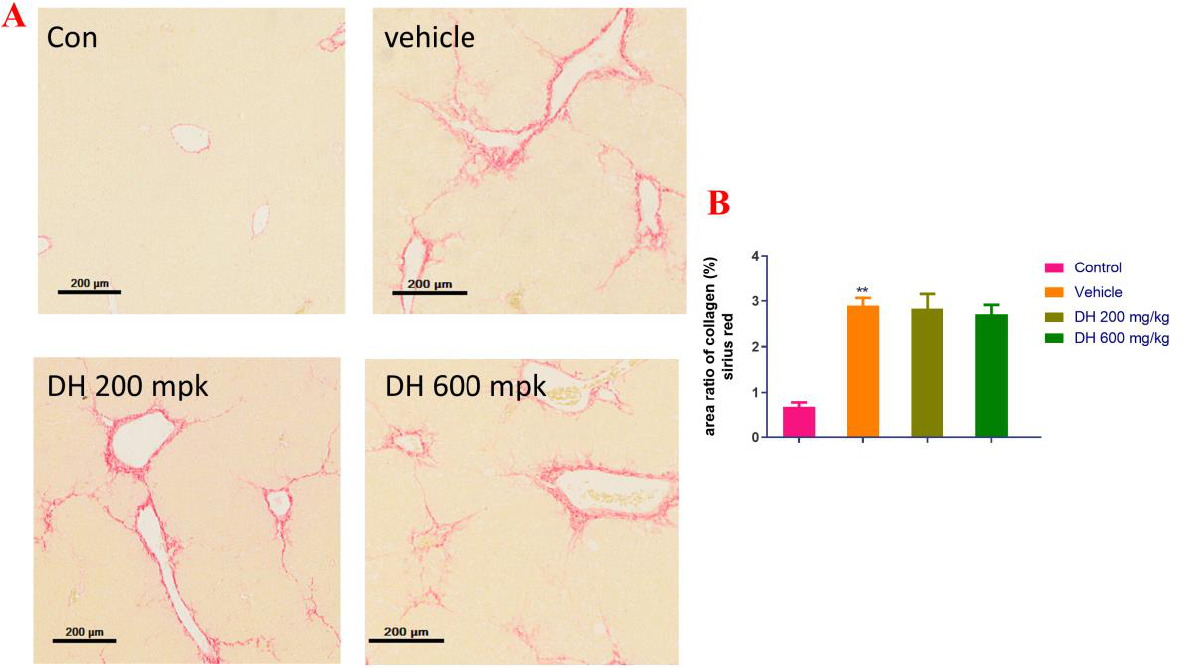
Figure 5. Pathological investigation of liver tissue sections in the CCl 4 -induced liver fibrosis mice stained with Sirius red. ( A ) Sirius red stained representative micrographs of liver sections from the studied groups of mice (200×), the ( B ) area ratio of collagen. DH 200 mg/kg: 200 mg/kg ethyl acetate extract; DH 600 mg/kg: 600 mg/kg ethyl acetate extract. Values are presented as mean ± SD ( n = 10). ** p < 0.01 vs. the control group